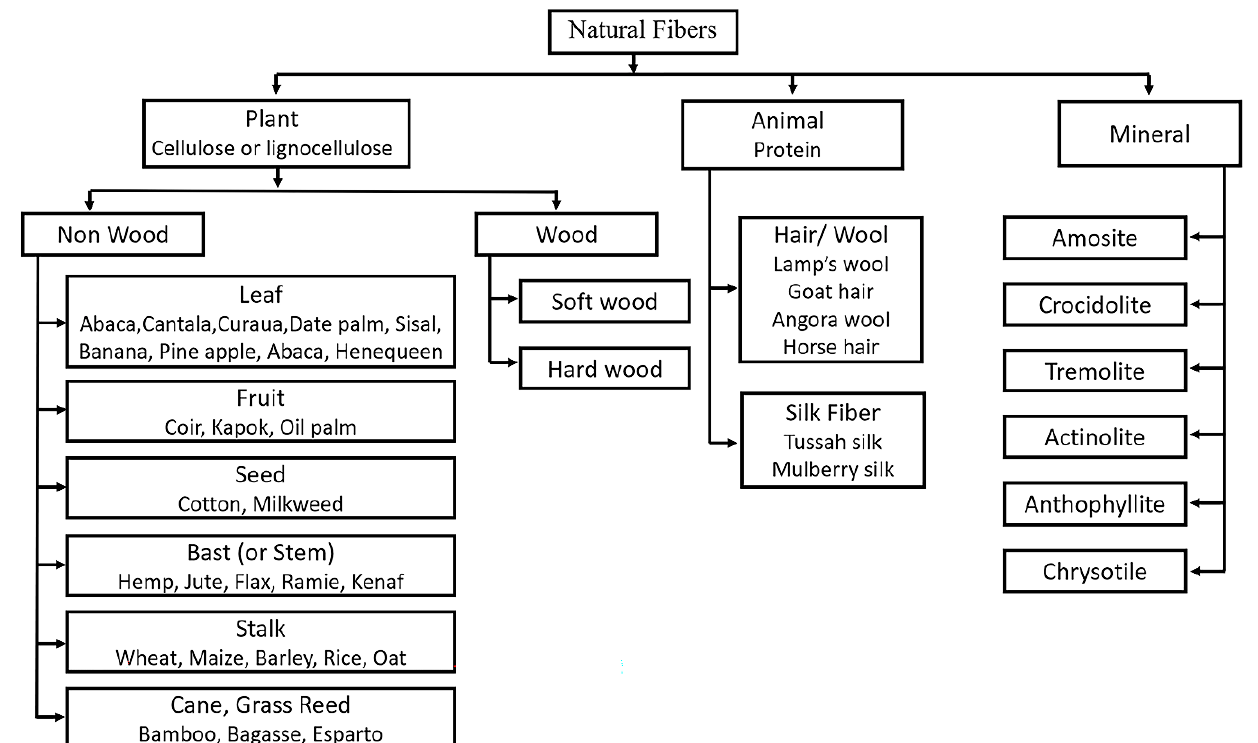
Figure 1. An overview of the classification of NFs.